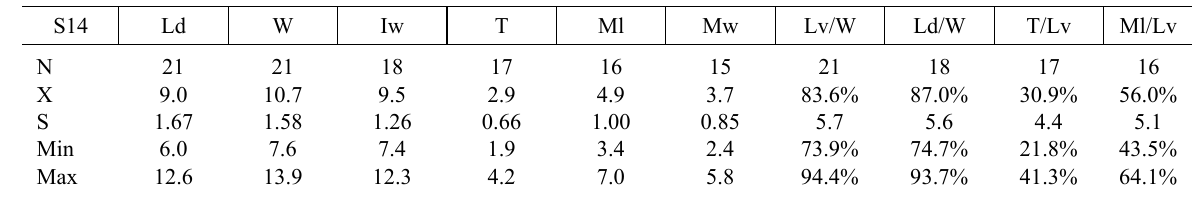
Table 2. Basic statistics of 21 dorsal valves of Isorthis ( Ovalella ) inflata sp. nov.; Llandovery, mid-late Aeronian, Niur Formation, sample S14, Derenjal Mountains